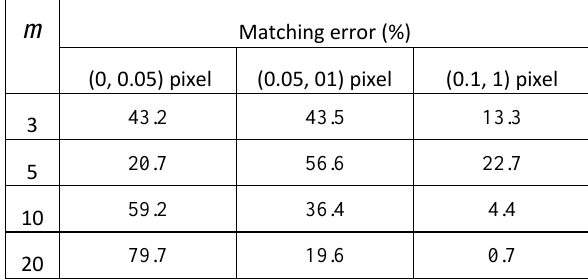
Table 1 the result of curved surface fitting phase correlation matching algorithm